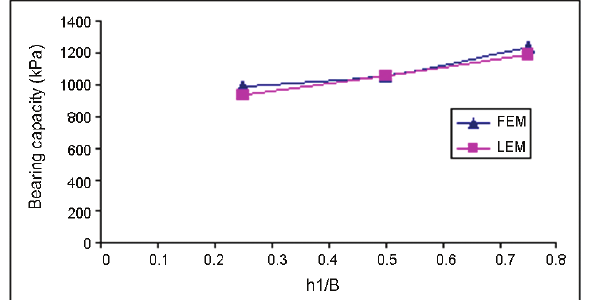
Fig. 4. Comparison of bearing capacity values with models (B = 2 m, L = B and ϕ 1 = 34° on ϕ 2 = 31°)